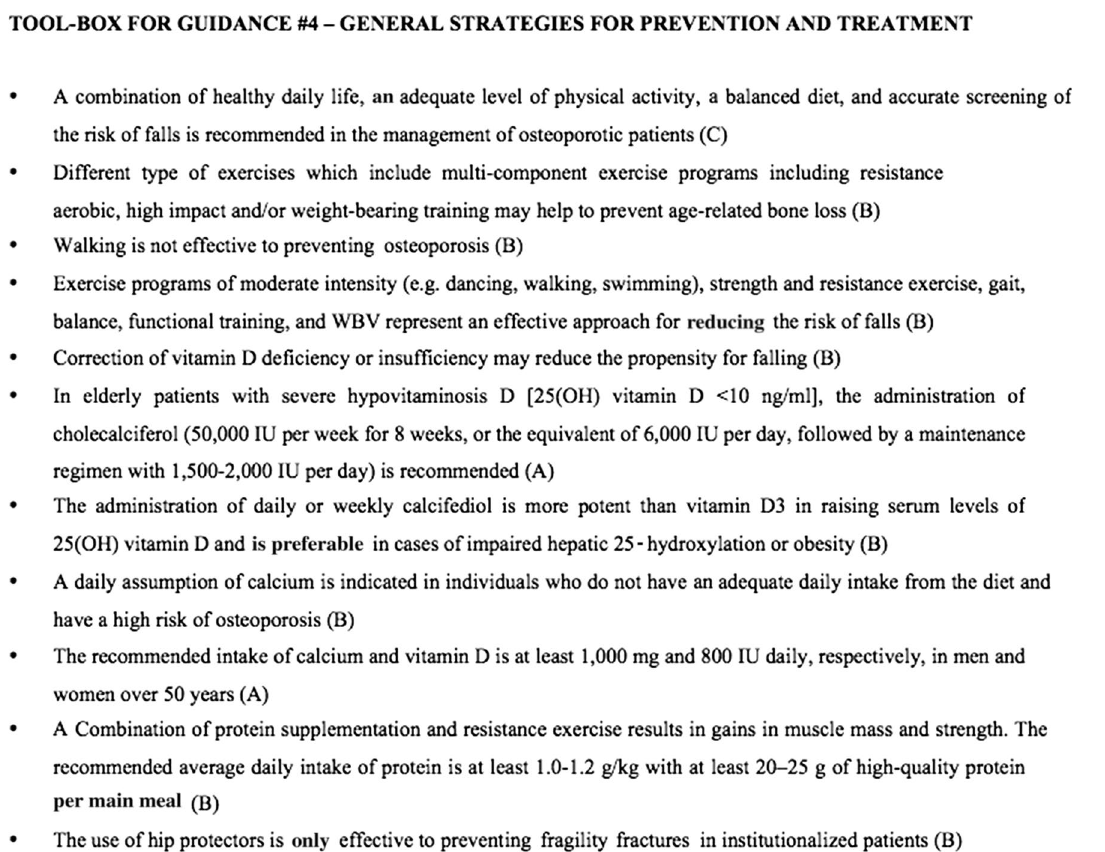
Fig. 4 Toolbox for guidance: general strategies for prevention and